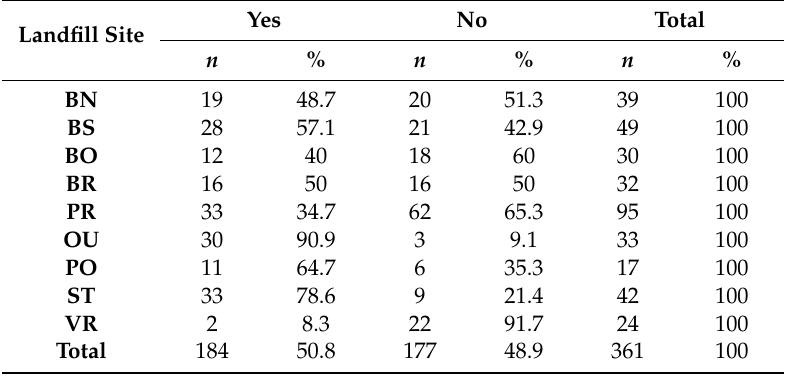
Table 10. Number of waste pickers collecting food from the landfill ( n =